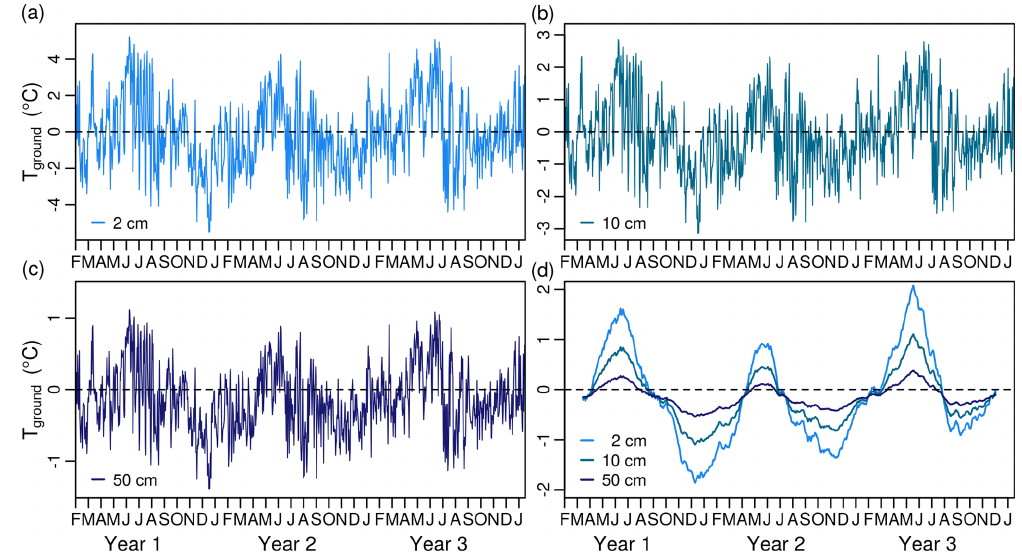
Figure 7. Simulated daily mean ground temperatures at (a) 2cm, (b) 10cm, and (c) 50cm depth on the southern Sanetti Plateau (3877m) corresponding to a decrease in air temperature of 7 . 1 ± 1 . 3 ◦ C and a decrease in global radiation of 30Wm − 2 relative to the present-day conditions. (d) Smoothed daily ground temperatures using a simple moving average with a window size of 91d, highlighting seasonal ground temperature